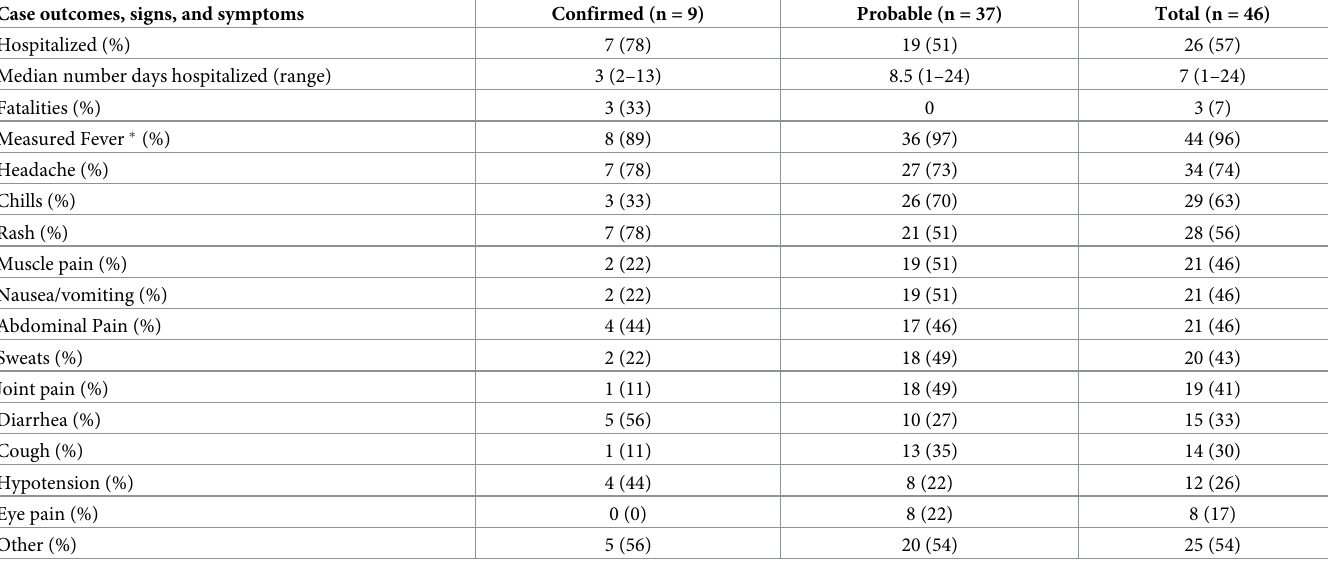
Table 3. Case outcomes, signs, and symptoms from electronically reported RMSF cases, 2011–2019. There was no statistical difference in proportions between con- firmed and probable cases for case outcomes, signs and symptoms (Z statistic for proportions, p > 0.05.). Case outcomes, signs, and